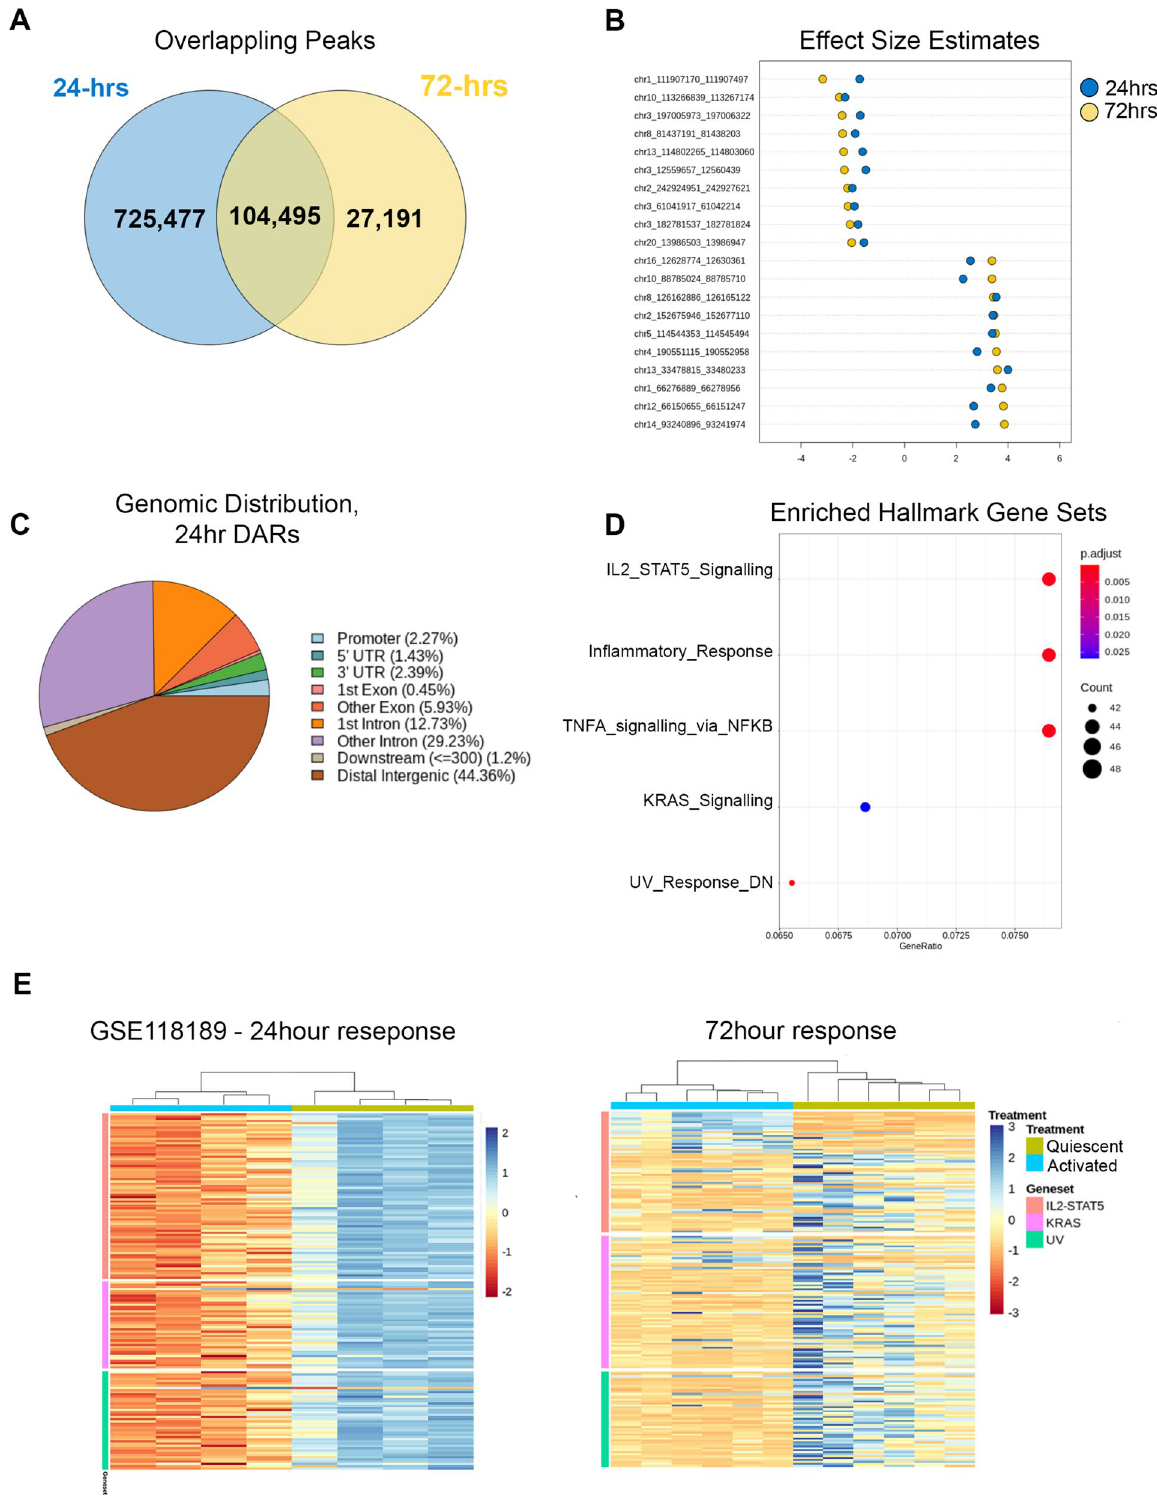
Figure 4. Reproducibility analysis with GSE118189. (A) Venn diagram of total detected overlapping peaks. (B) Dot chart of logFC effect size estimated for top 20 reproducible peaks. Data for all peaks are shown in Fig S4. (C) Pie chart of genomic distribution of 4,387 differentially accessible regions (DARs) at 24-h post activation (GSE118189). (D) Gene sets enrichment analysis of 4387 DARs. (E) Cluster heatmap of differentially accessible peaks annotated at 24 and 72 h. Rows represent peaks, columns represent samples. Cells are colored according to row-scaled read counts. Columns are clustered by Euclidean distance with complete